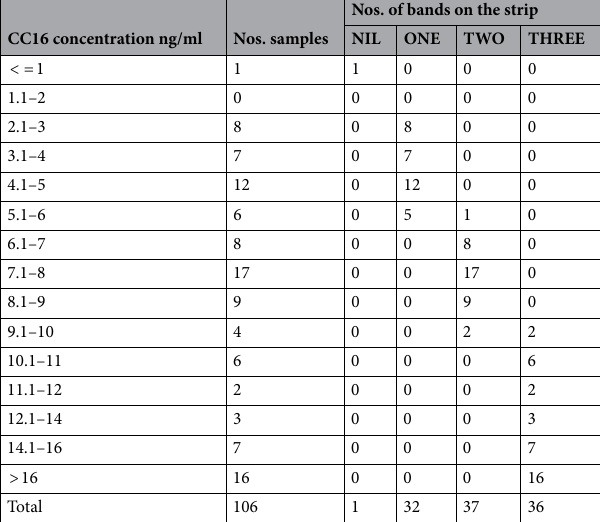
Table 2. Performance evaluation of lateral flow assay for semi-quantification of CC16 in 104 serum samples in comparison with ELISA. NB—only three samples were discordant (two had > 9 ng/ml and one had < 6 ng/ml) and did not match with the expected ELISA